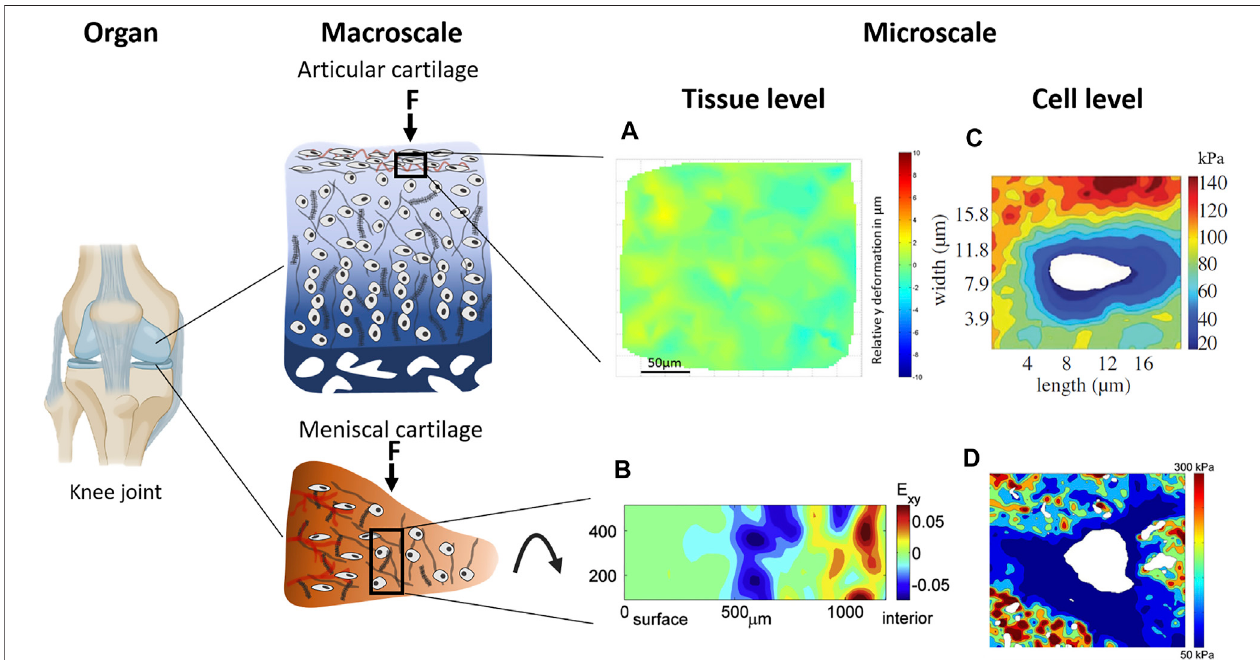
FIGURE 3 | Multiscale strain transfer in articular and meniscal cartilage occurs from the organ to macroscale and microscale. Tissue strains resulting from mechanical compression and tensile loading are non-uniform. (A) Heterogeneous strain in the super fi cial zone of ex vivo equine articular cartilage at 38% compressive strain demonstrated by (Mans fi eld et al. 2015), and (B) heterogeneous strain distribution in the central region of ex vivo bovine medial meniscal cartilage at 10% compressive strain demonstrated by (Lai et al. 2010). Stiffness maps of the PCM measured with atomic force microcopy reveal a softer PCM compared to the surrounding ECM in both (C) the super fi cial zone of human articular cartilage and (D) the middle zone of human meniscal cartilage. Panel (A) from (Lai et al. 2010), (B) from (Han et al. 2016), (C) from (Wilusz et al. 2012), and (D) from (Sanchez-Adams et al. 2013) used with permission.